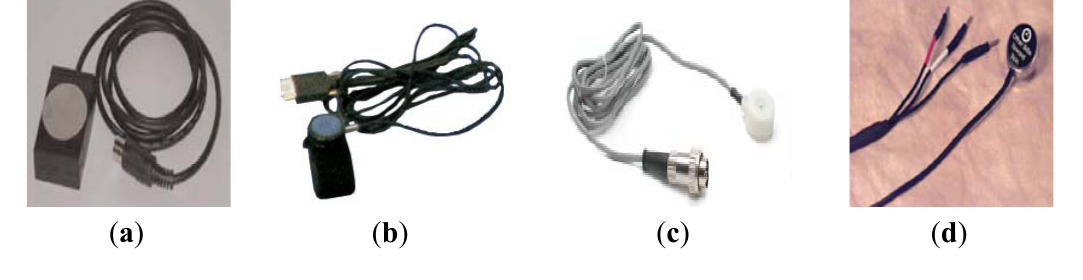
Figure 2. Example of phonocardiography sensors ( a ) HSM-300 Heart sounds Monitor from IWORK; ( b ) Heart sounds microphone model 50-4724 from MindWare; ( c ) MLT 201 Cardio Microphone from ADinstruments; ( d ) Physiological Sounds Microphone Model AH153 from Biopac